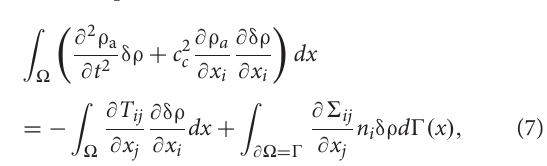
analogy based on the fluctuation of acoustic density ρ a = ρ − ρ